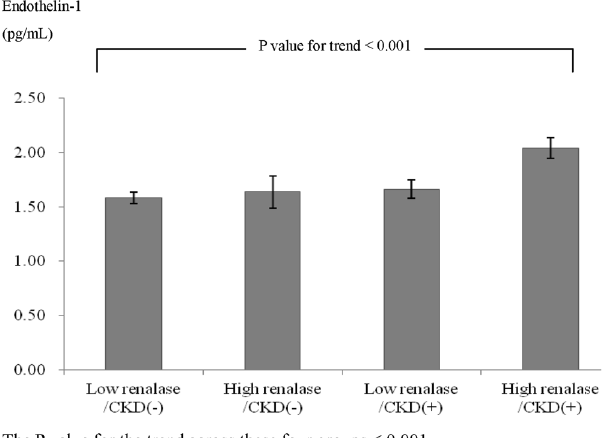
Figure 1. Serum endothelin-1 concentrations and standard error bars in different groups stratified by serum renalase levels and the presence of chronic kidney disease